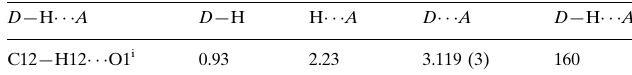
Hydrogen-bond geometry (A˚ , (cid:3)